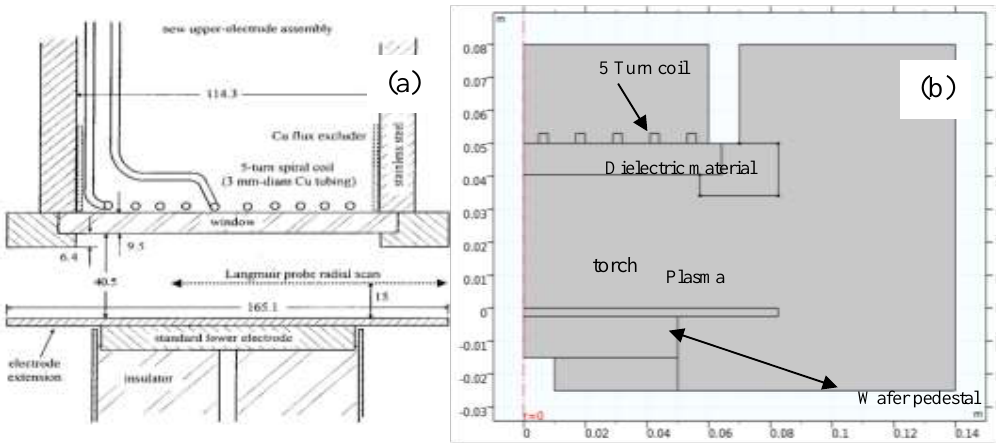
Figure 1: The Simulation domain in two-dimensions, a) the GEC geometry [18] b) cross section of the